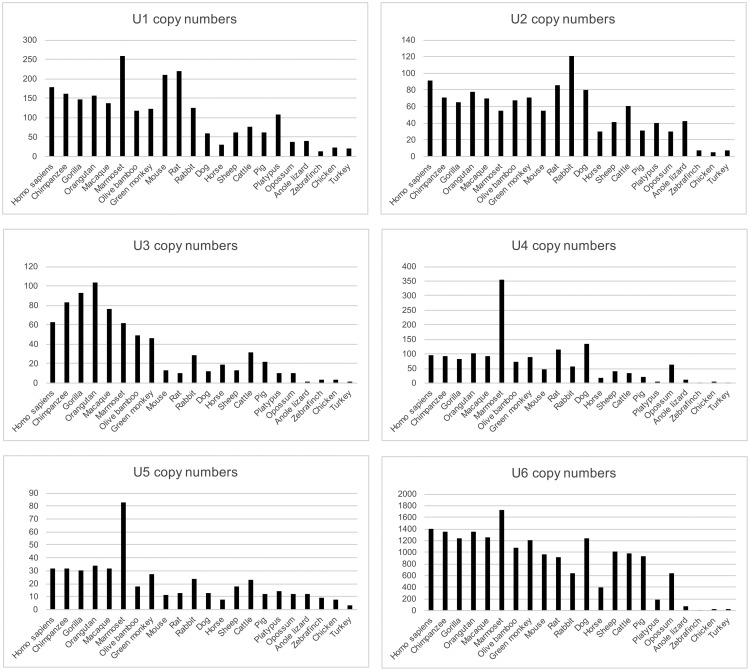
SnRNA and U3 snoRNA copy number variation across 23 amniote genomes (EnsEMBL release 83). U1–U3 small RNAs exhibit notable expansions with the advent of mammals, with individual families expanding to dozens (U1–U5) or hundreds (U6) of copies in any given genome.